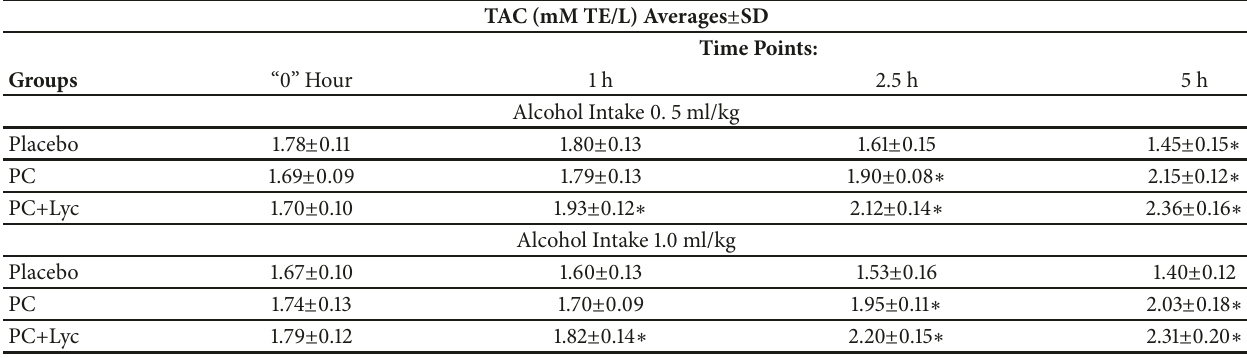
Table 3: C hanges in total antioxidant capacity (TAC) of serum. The volunteers were enrolled, screened, and randomized as described in the Material and Methods and given study products as well as alcohol-containing beverages. The parameters were measured at “0” hours and after 1, 2.5, and 5 hours following the